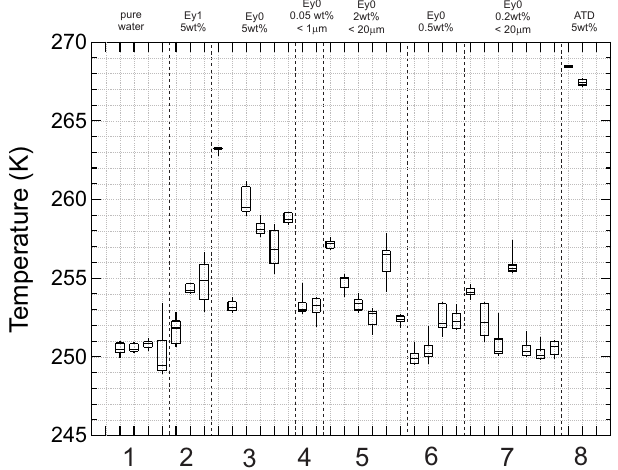
Fig. 3. Bulk freezing temperatures for different suspensions con- taining ash, and for comparison Arizona test dust. Sets of exper- imental runs for samples from each suspension are separated by vertical lines. Suspensions: 1 – pure water; 2 – Ey1, 5wt%; 3 – Ey0, 5wt%; 4 – Ey0, 0.05wt%, particles larger than 1µm settled out; 5 – Ey0, 2wt%, particles larger than 20µm settled out; 6 – Ey0, 0.5wt%; 7 – Ey0, 0.2wt%, particles larger than 20µm settled out; 8 – Arizona test dust, 5wt%. For each experimental run (8– 10 cooling and warming cycles performed with one sample), boxes show median values and upper and lower quartiles, whiskers show extreme values.